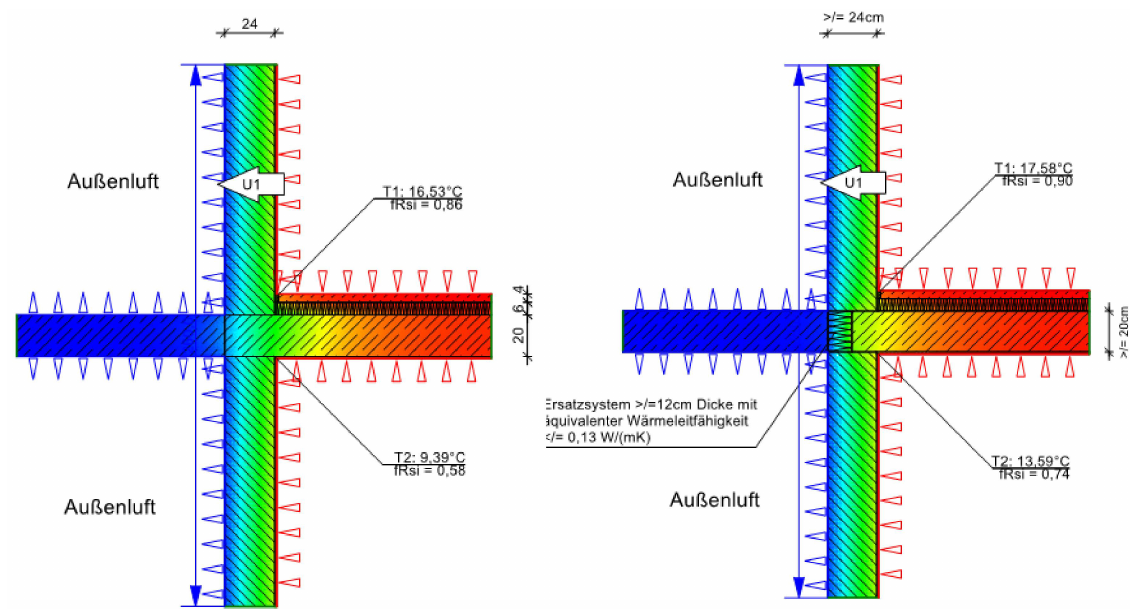
Figure A10. Before and after the thermal bridge retrofit of a balcony slab (created with ThermCad thermal bridge simula- tion calculator). Table A12. Retrofit components and costs of the thermal bridge retrofit of a balcony slab [38,39]. Pos. No.